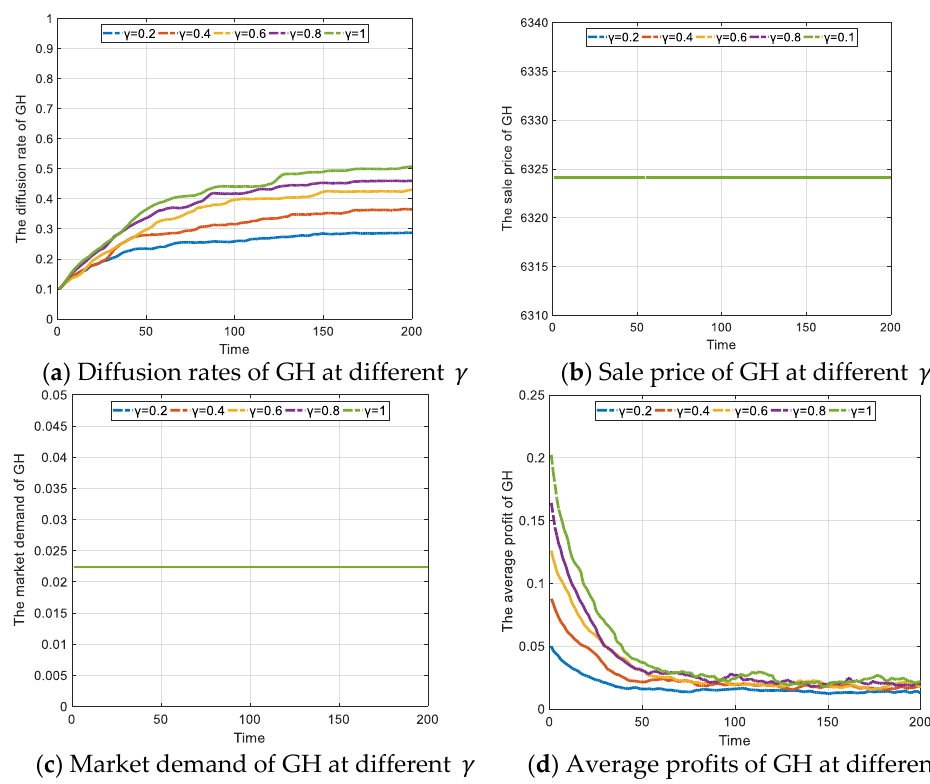
Figure 4. The effect of preferential policy on GH diffusion (Unit: CNY).